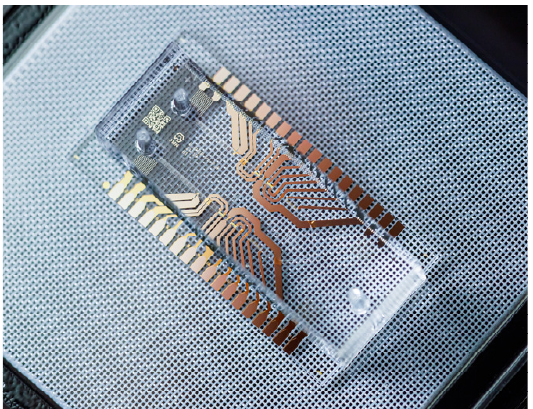
Figure 15. Lab-on-a-chip device for microfluidic applications. The dimensions of the channels are 50 µ m high × 200 µ m wide. The detection system is made up of metal electrodes on a glass substrate [103].